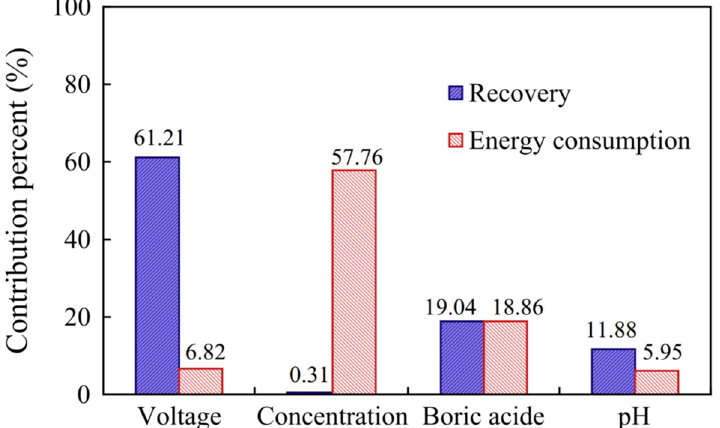
Figure 5. The contribution percent of the parameters (voltage, concentration, boric acid, and pH) of electrodeposition on Ni recovery and energy consumption. Reproduced with permission [68] . Copyright 2014, Elsevier.